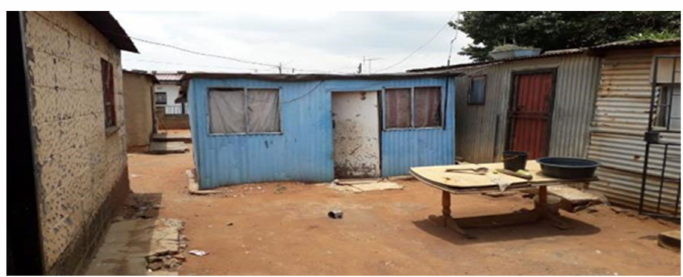
Figure 5. A typical backyard shack in the Kathorus area, shacks are usually no older than 10 years. Each backyard shack houses between one to three occupants. Shacks are usually made with corrugated iron and any scavenged materials. The number of windows was not standard, they were between 2 and 3. Shacks generally had a floor area of about 20–25 m 2 .